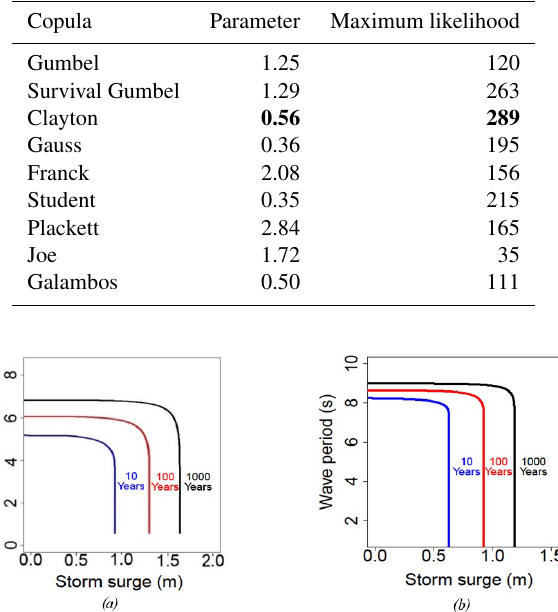
Table 6. Log-likelihood and copula parameter for different bivariate copulas between F H,T and F s . Copula Parameter Maximum likelihood Gumbel